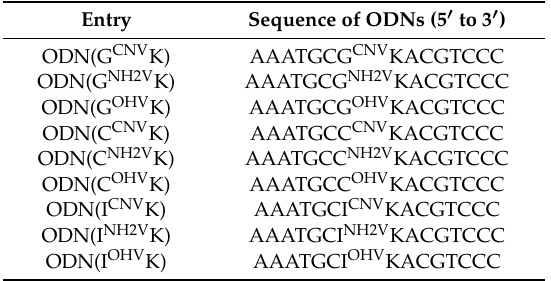
Table 1. The sequence of oligodeoxyribonucleic acid (ODN) containing